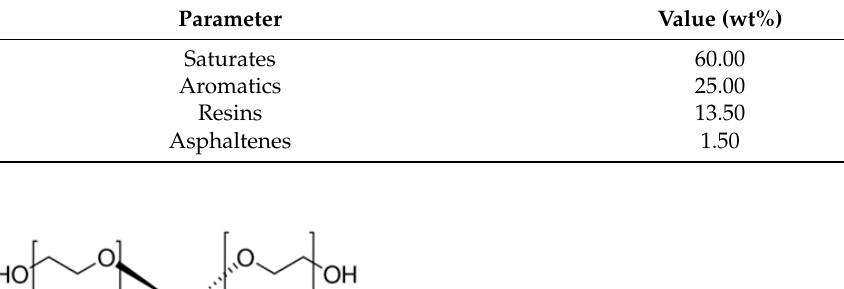
Table 2. Chemical properties of Tapis crude oil.